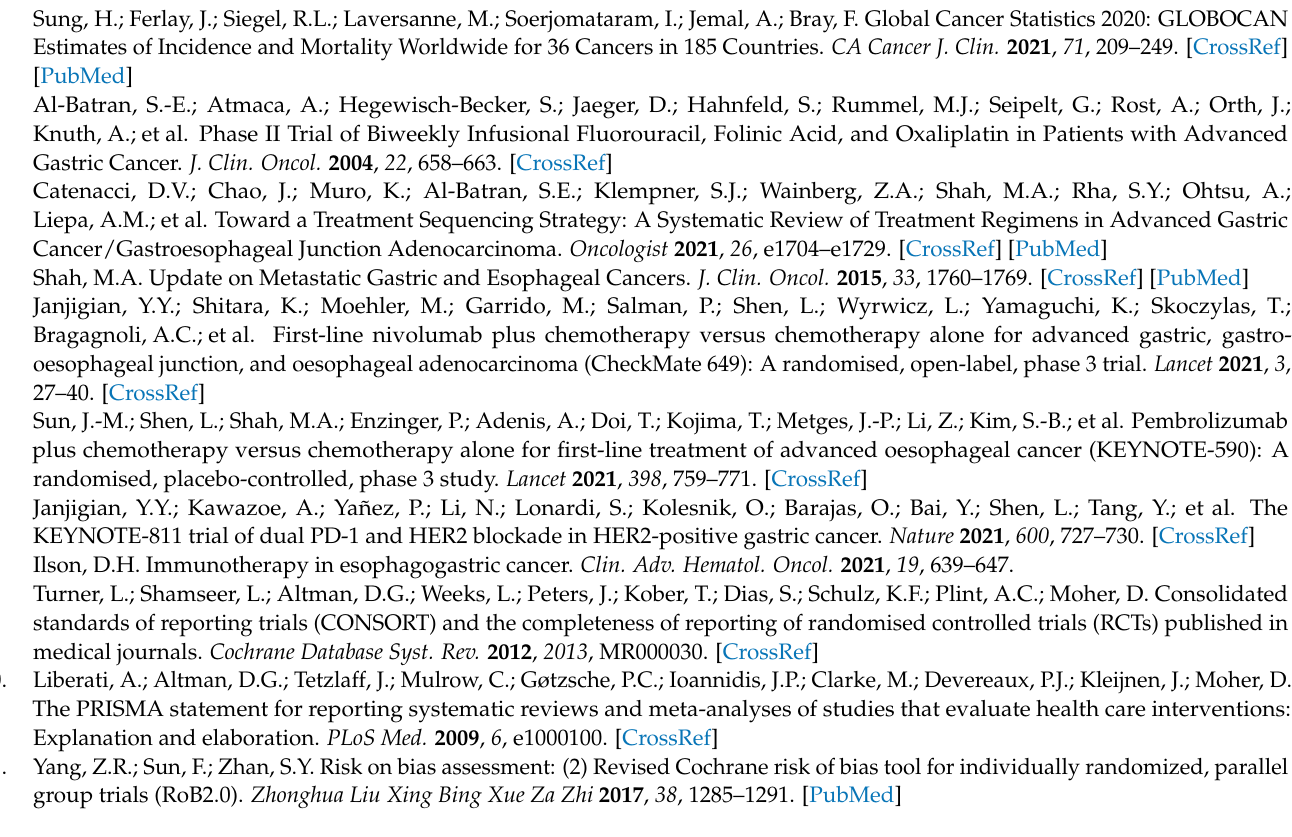
survival in males; B. Forest plot for overall survival in females. Figure S5: Immune checkpoint inhibitor vs. chemotherapy: A. Forest plot for overall survival; B. Forest plot for progression free survival. Figure S6: Immune checkpoint inhibitor vs. chemotherapy: A. Forest plot for overall survival in Asians; B. Forest plot for overall survival in Whites. Figure S7: Immune checkpoint inhibitor vs. chemotherapy: A. Forest plot for overall survival in males; B. Forest plot for overall survival in females. Figure S8: Overall survival in immune checkpoint inhibitor vs. chemotherapy: A. First-line setting; B. Second-line setting. Figure S9: Funnel plots for A. Treatment related adverse event (TRAE); B. Any adverse event (AE); C. Grade 3+ related AE; D. Progression free survival, E. Overall